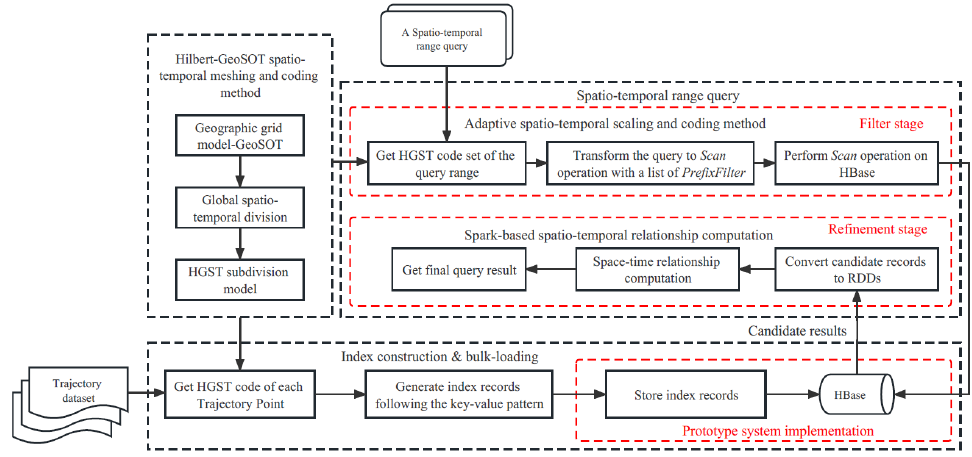
Figure 1. Overview of the proposed method (the lower part shows the process of index construction for trajectory, and the upper right part shows the process of spatio-temporal range